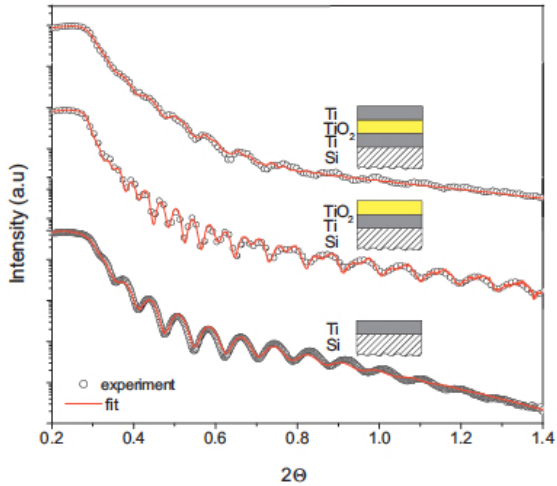
Figure 5. By fitting parameterized equations to each of the three X-ray reflectivity data traces above, it can be determined that the base Ti layer is 47nm thick on the lowest trace; both the Ti and TiO 2 layers are 46nm thick in the center trace; and the three layers on the top trace are 40nm, 51nm and 49nm, respectively, on the top trace, demonstrating a distinct decrease in accuracy with increasing film thickness. (Reprinted from [48], Copyright Elsevier,